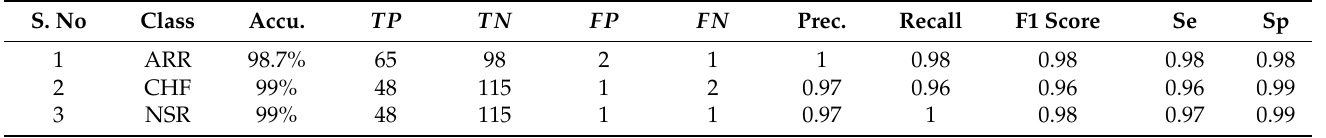
Figure 11. ( a ) Training progress and validation accuracy of proposed model without K-fold cross validation ( b ) training and progress loss of proposed model without K-fold cross validation. Table 6. The table represents overall accuracy, TP , TN , FP , FN , F1, Sensitivity (Se), and specificity (Sp) score for 2DCNN-LSTM model with k-fold